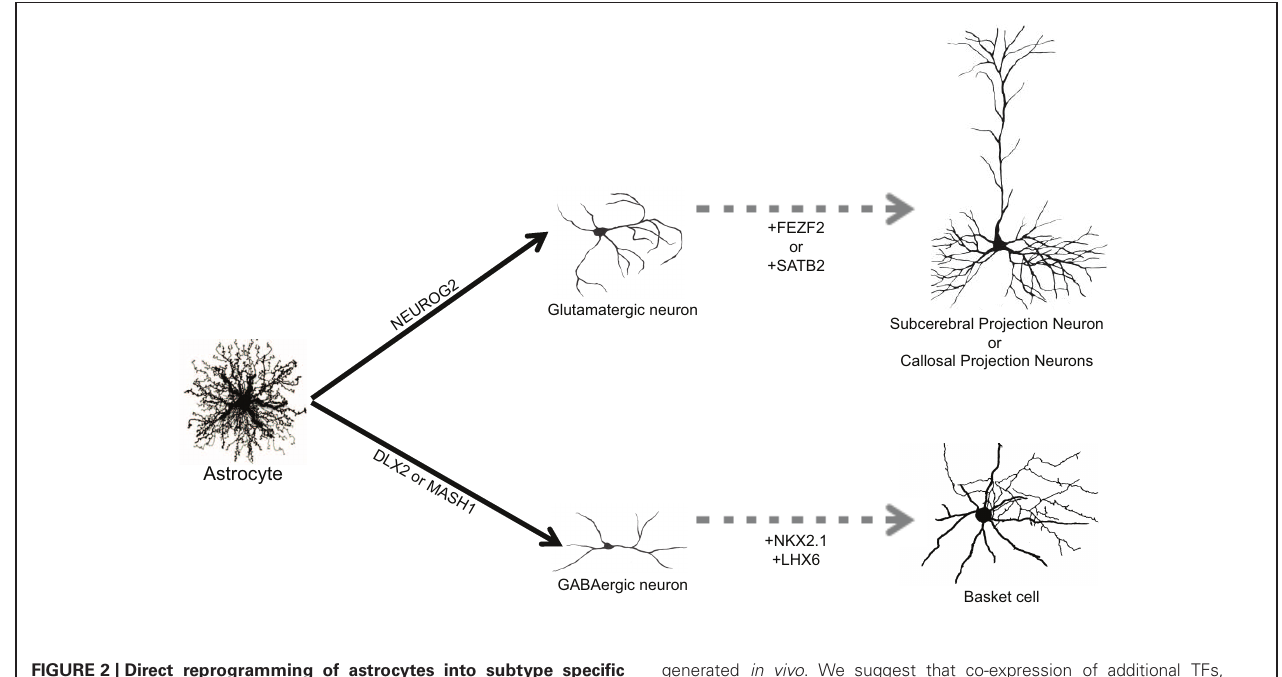
FIGURE 2 | Direct reprogramming of astrocytes into subtype specific neurons. Astrocytes can be converted into glutamatergic neurons by forced expression of NEUROG2 and into GABAergic neurons following expression of DLX2 and MASH1 (filled arrows). Up to now, it is unknown which subtype of glutamatergic and GABAergic will be